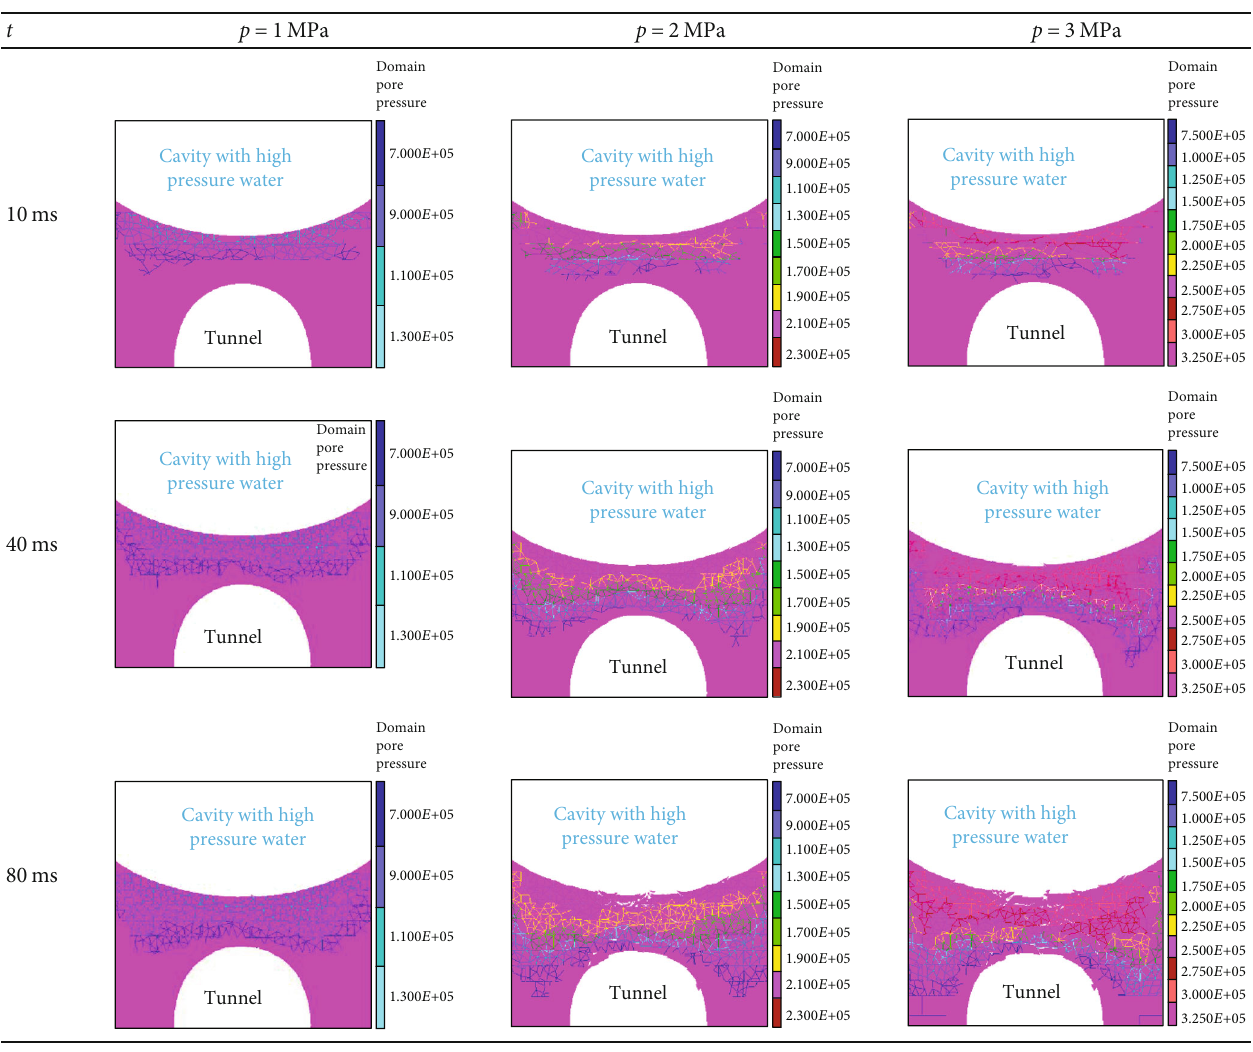
Table 4: The seepage pressure distribution in the water-resistant strata under the three cases of p = 1 , 2, and 3 MPa at t = 10 , 40, and